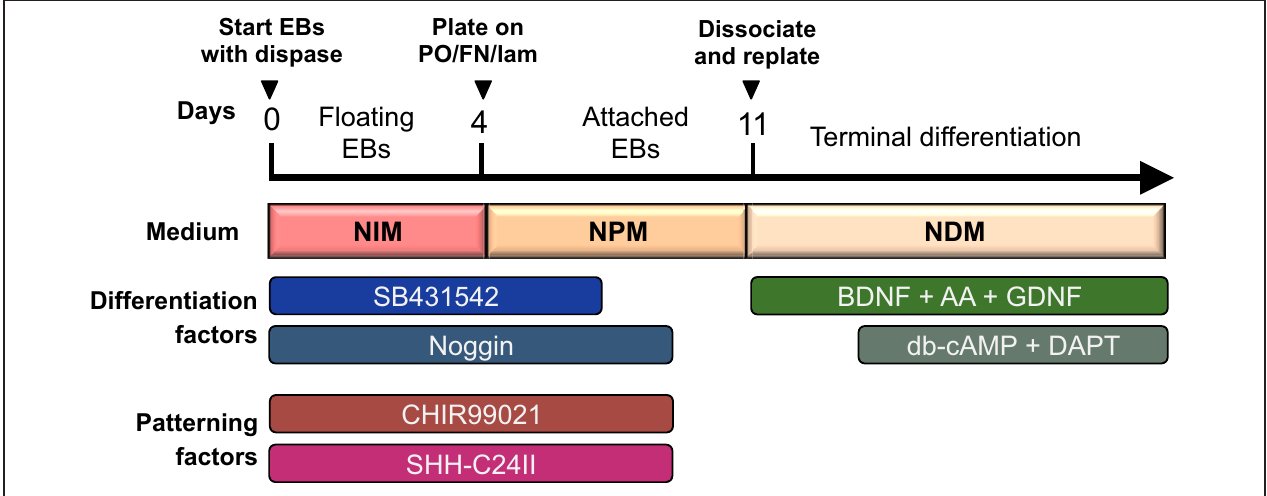
patterning factors are present between day 0–9 (only SB431542 is withdrawn at day 7), and terminal differentiation is initiated from day 14 and onward with db-cAMP and